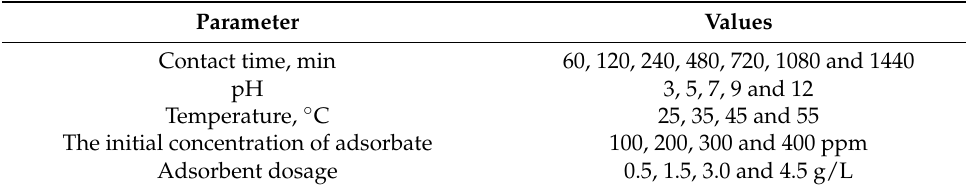
Table 2. Parameters for batch adsorption